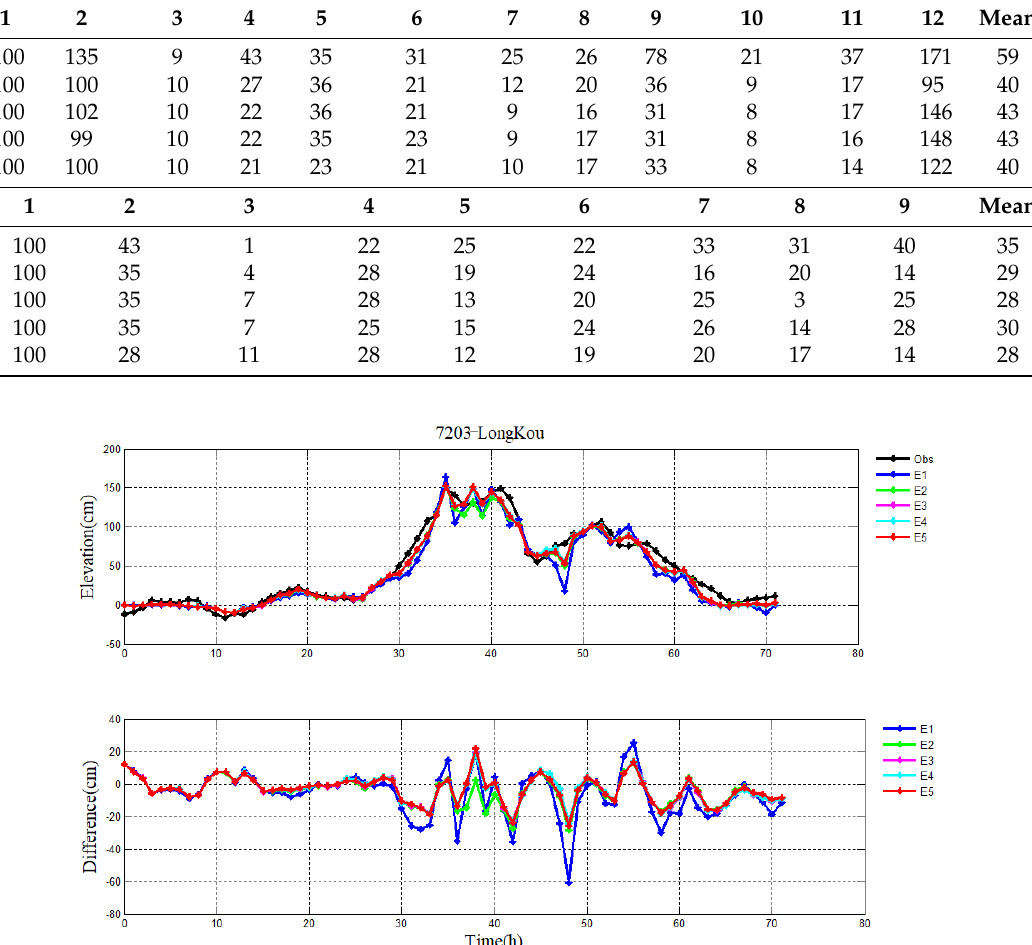
Table 6. Relative errors between simulated and observed storm surge levels at LongKou and Shi-